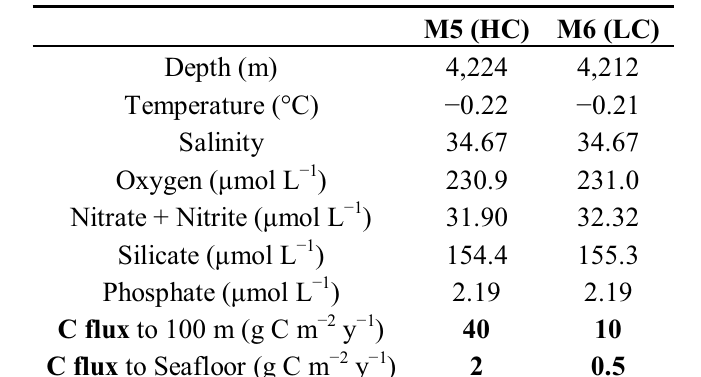
Table 1. Bottom water properties, Austral summer 2004 (cid:177) 2005. HC: high-chlorophyll; LC: low-chlorophyll. Data reproduced from [18] and